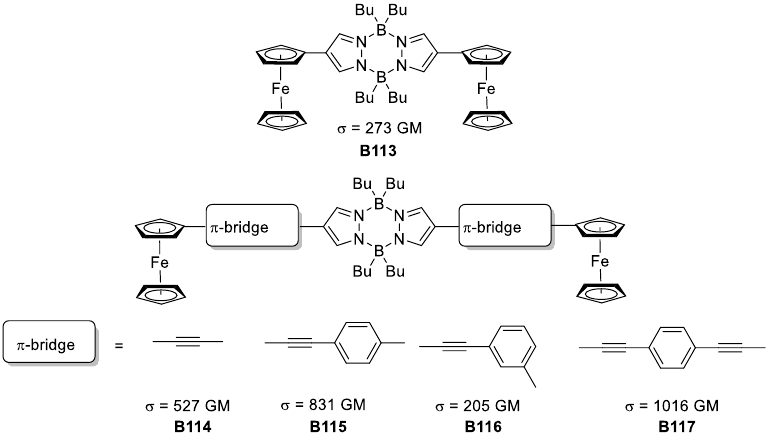
Figure 36. Quadrupolar molecules based on pyrazabole π-bridged with ferrocene.